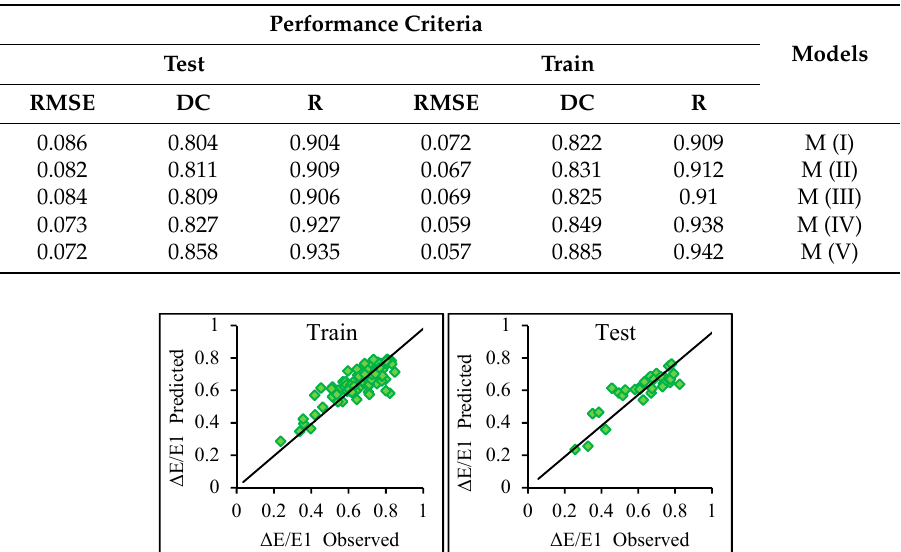
Figure 5. Comparison of observed and predicted relative energy dissipation for the trapezoidal shape channel superior model.